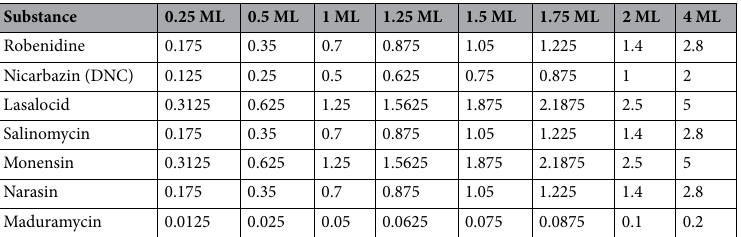
Table 1. Concentrations of individual coccidiostats in the feed samples used to plot the calibration curve points listed in the table (mg/kg).